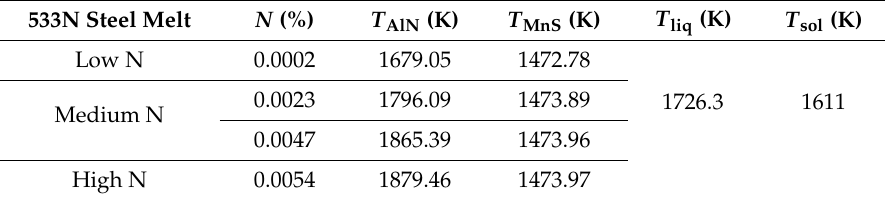
Table 4. The temperature of liquidus, solidus, AlN, and MnS inclusion formation in the steel. 533N Steel